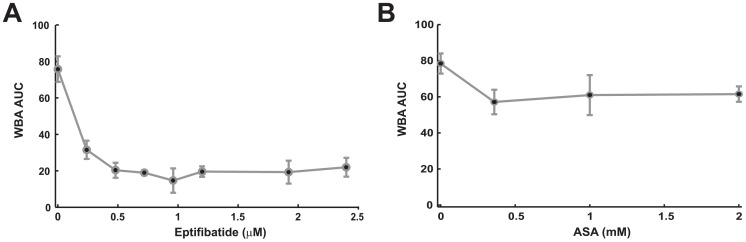
Dose-response measurement using a low shear impedance aggregometer.Plots show results from its Area Under the (Impedance) Curve (AUC) aggregometer metric after the addition of platelet therapies eptifibatide (A) and ASA (B).